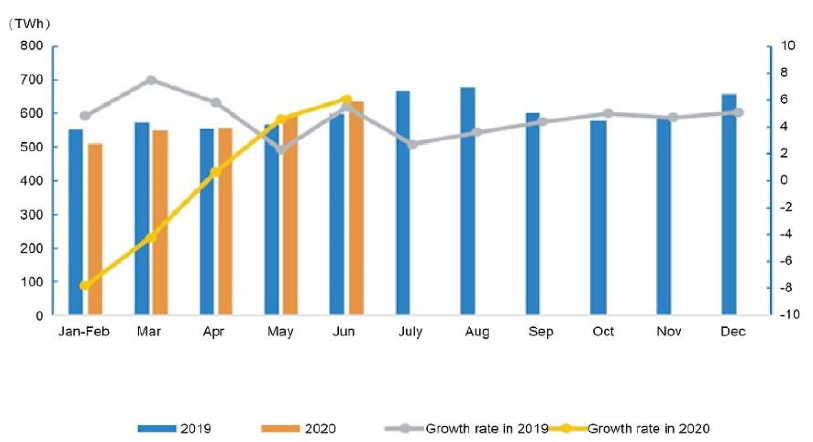
Figure 9. Electricity consumption and its growth rate by month in 2019 and 2020 [37]. Source: CEC (2020) Statistics of Electricity Consumption. All rights reserved.